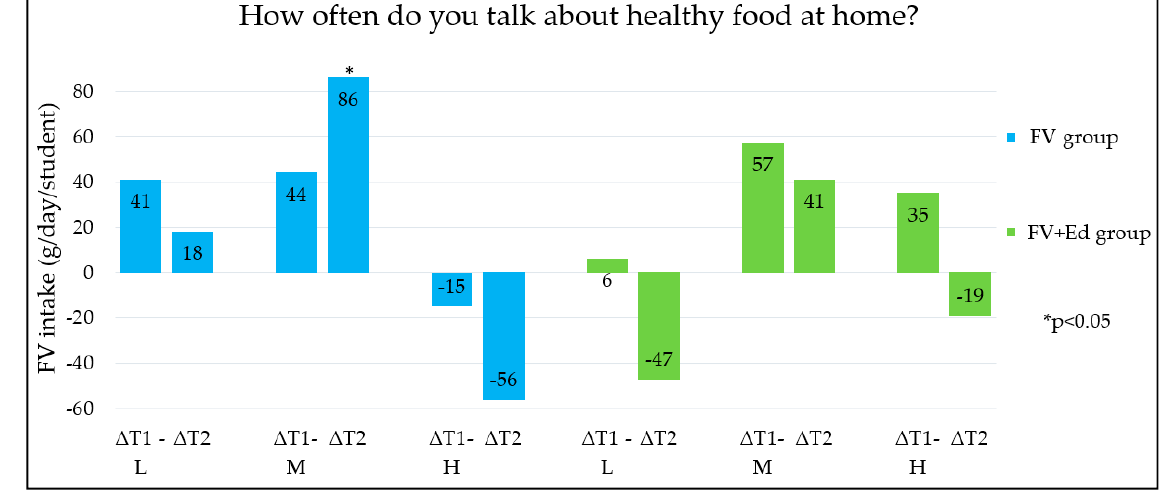
Figure 5. Differences in children’s FV intake, stratified by caregivers’ HPB (L = low HPB, M = medium HPB, H = high HPB) in FV- and FV+Ed group, compared to the control group—Talking about healthy food. HPB = caregivers’ health promotion behaviour, ∆ T1 = Difference between T0 and T1, ∆ T2 = Difference between T0 and T2.